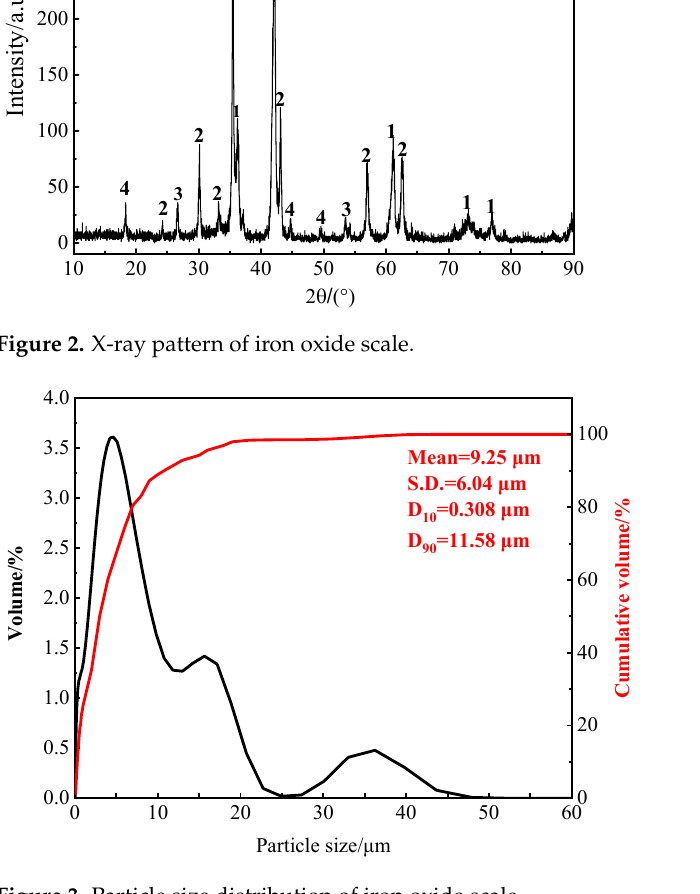
Figure 3. Particle size distribution of iron oxide scale. Table 3. Basic information about auxiliary